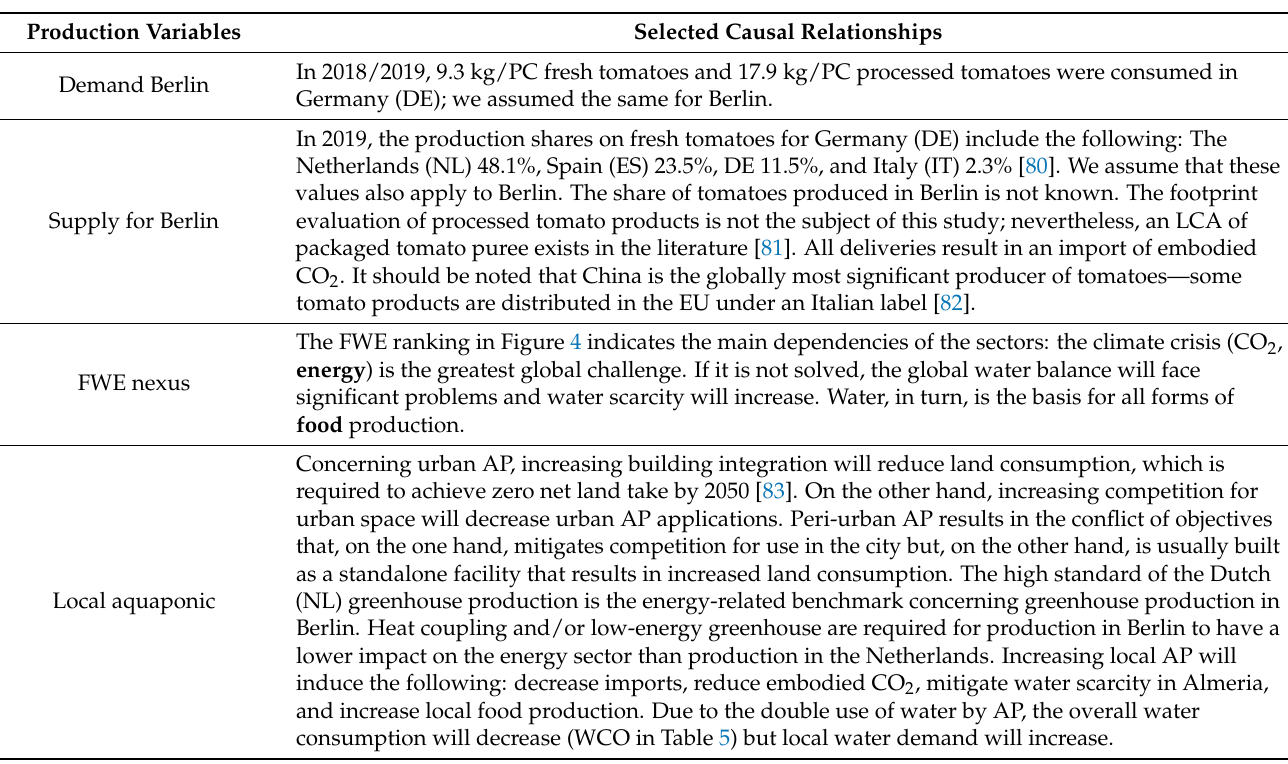
Table 6. Causal relations of significant tomato production-location